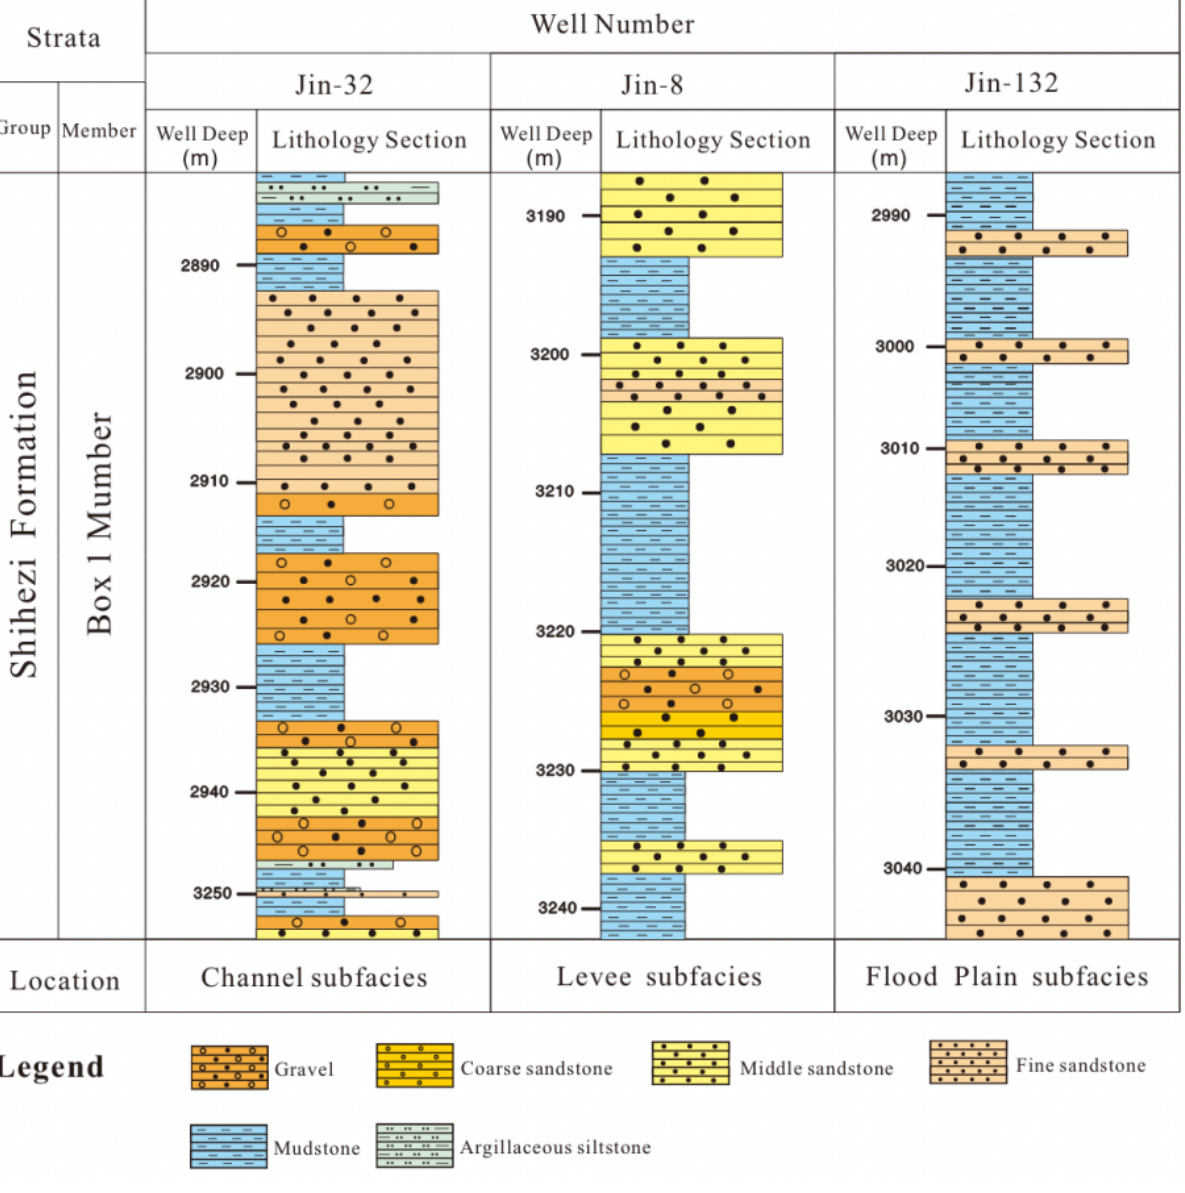
Figure 5. Classification of borehole fluvial facies in core profiles of the Hangjinqi gas field (Target domain,